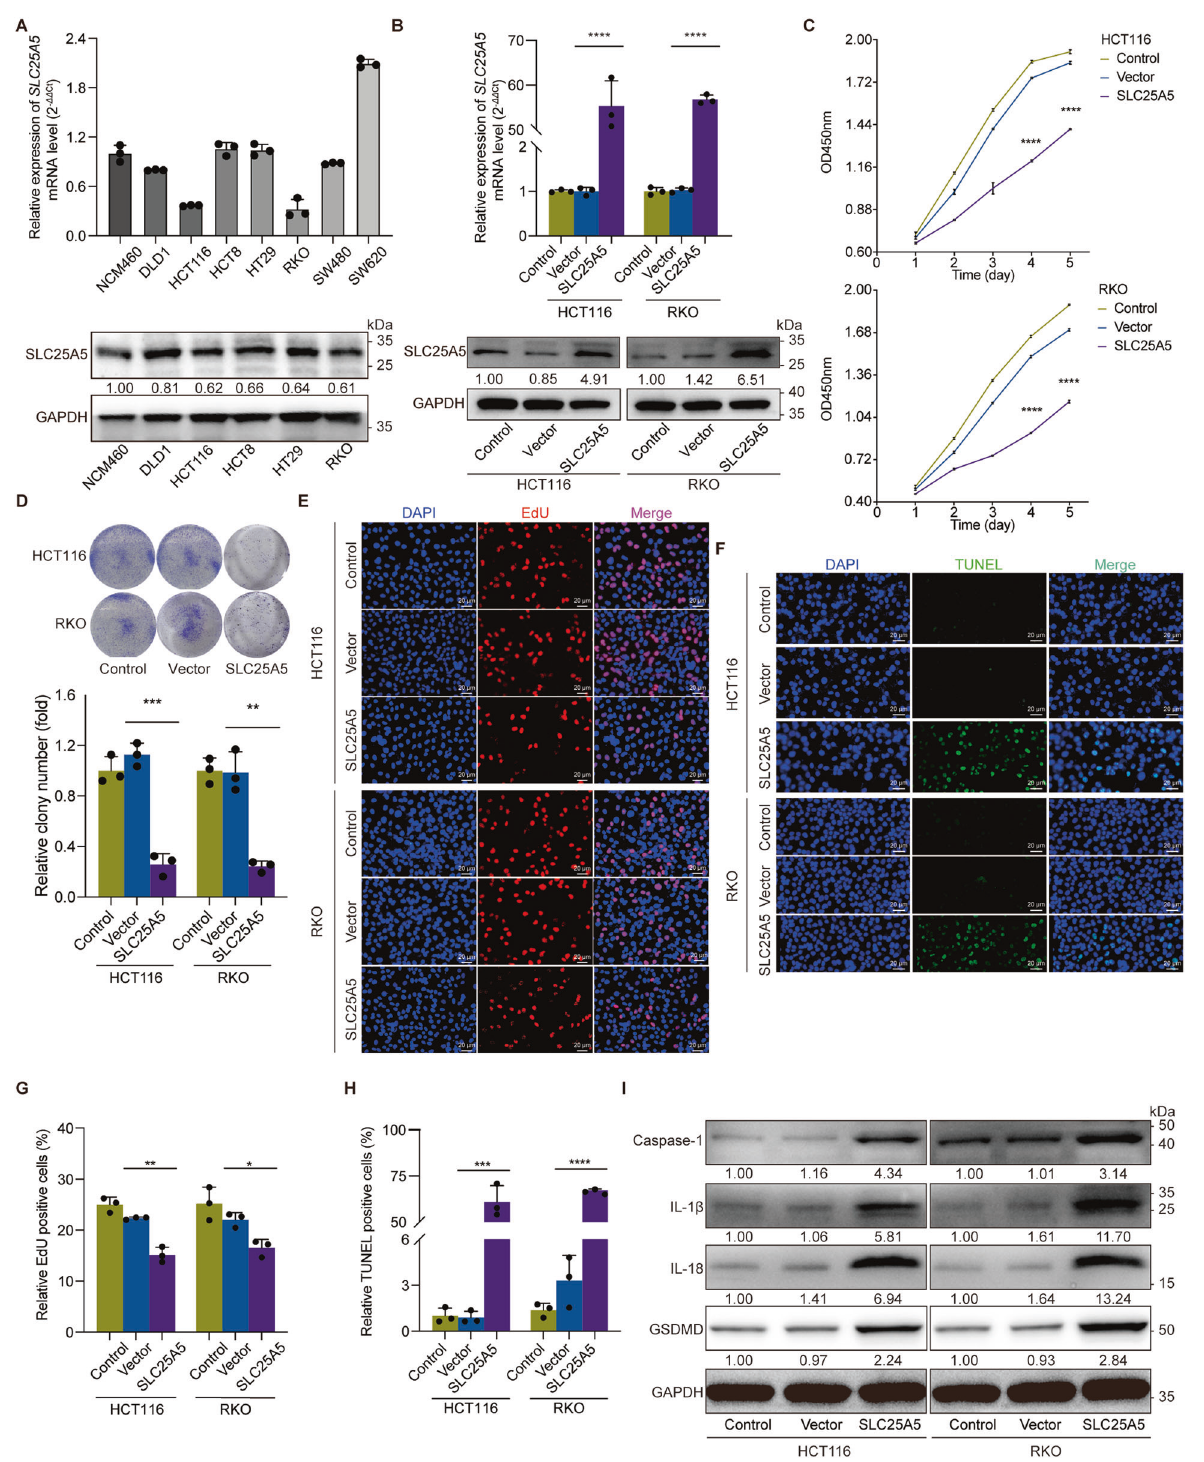
Fig. 7 SLC25A5 repressed tumorigenesis and upregulated programmed cell death signaling in vitro. A The baseline expression of SLC25A5 at the mRNA and protein levels was examined in one human colonic epithelial cell line (NCM406) along with colon cancer cell lines (DLD1, HCT116, HCT8, HT29, RKO, SW480, SW620). B SLC25A5 was overexpressed by lentiviral transfection in HCT116 and RKO cells. Their expression levels were re-examined by RT – qPCR and western blotting. C , D Upregulation of SLC25A5 contributed to attenuating tumorigenesis, which was evaluated by CCK-8 assay ( C ), colony formation assay ( D ), and EdU ( E ) and TUNEL ( F ) staining. G , H Quanti fi cation of EdU and TUNEL staining. I Upregulation of SLC25A5 inhibited the expression of programmed cell death-related biomarkers, such as Caspase- 1, IL-1 β , IL-18, and GSDMD. GAPDH protein was used as the internal control. n = 3 biological replicates. Scale bar = 20 μ m. Statistical analysis: Student ’ s T test, * p < 0.05, ** p < 0.01, *** p < 0.001, **** p <